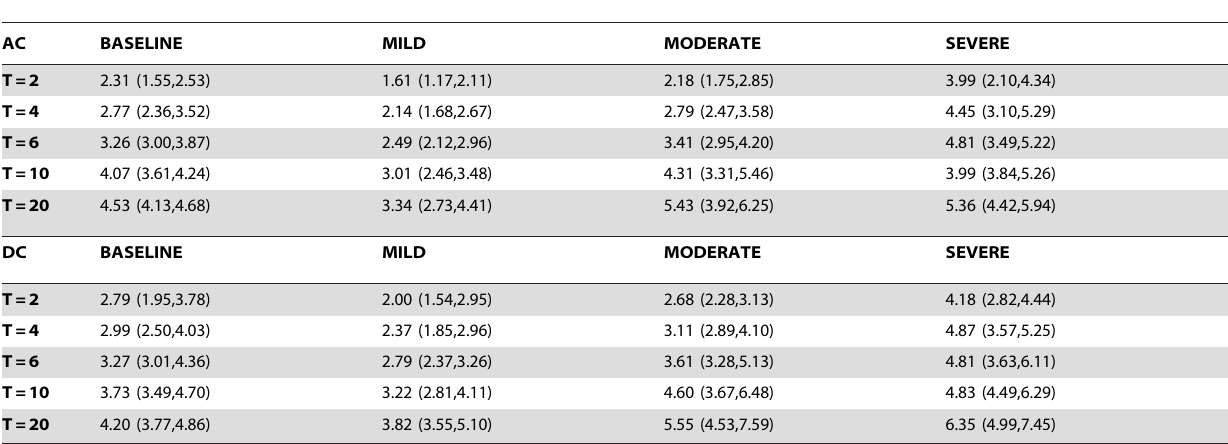
Table 5. AC and DC absolute median values (in ms) when considering stable (concatenated baseline segments free of FHR decelerations) fRR